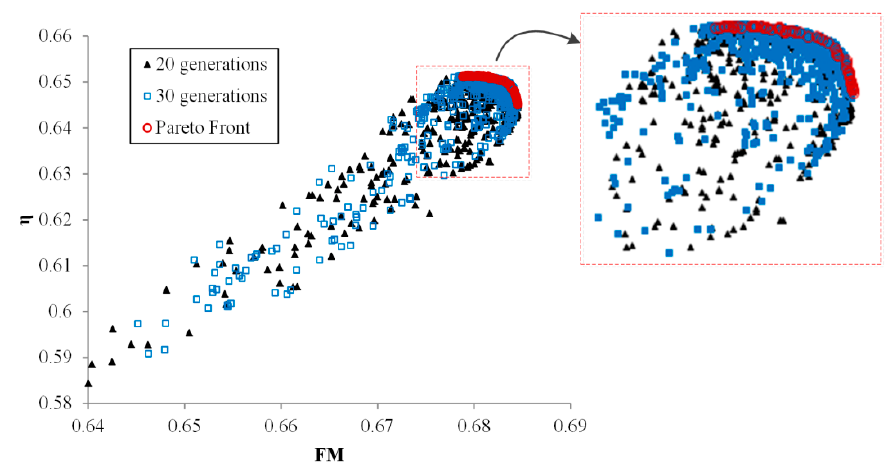
Figure 13. Sensitivity analysis results under different generation numbers in multi-objective optimization (the Pareto front in the red circle is from the 20 generations case.).